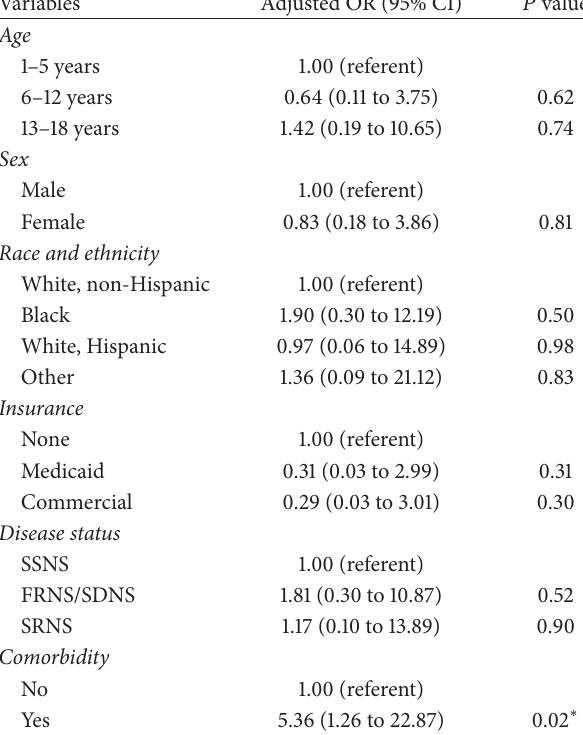
Table 5: Association between patient characteristics and serious